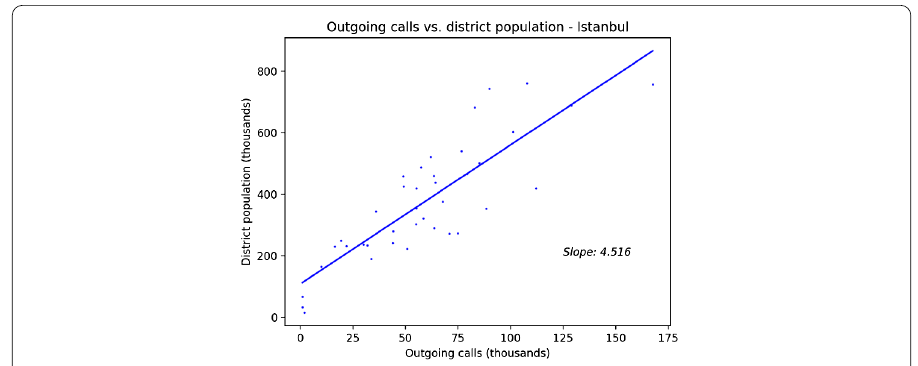
Figure 7 Observed relationship between the amount of communications originated in each district of Istanbul and the population living in the district. We confirm a linear relationship as expected. Using this relationship to make an estimate indicates that there are about 565,000 refugees living in Istanbul. This is above the 400,000 number cited by public authorities. On the other hand, using the relationship to estimate the local population of the city returns a figure of 10,000,000 people, below the official count of 13,500,000